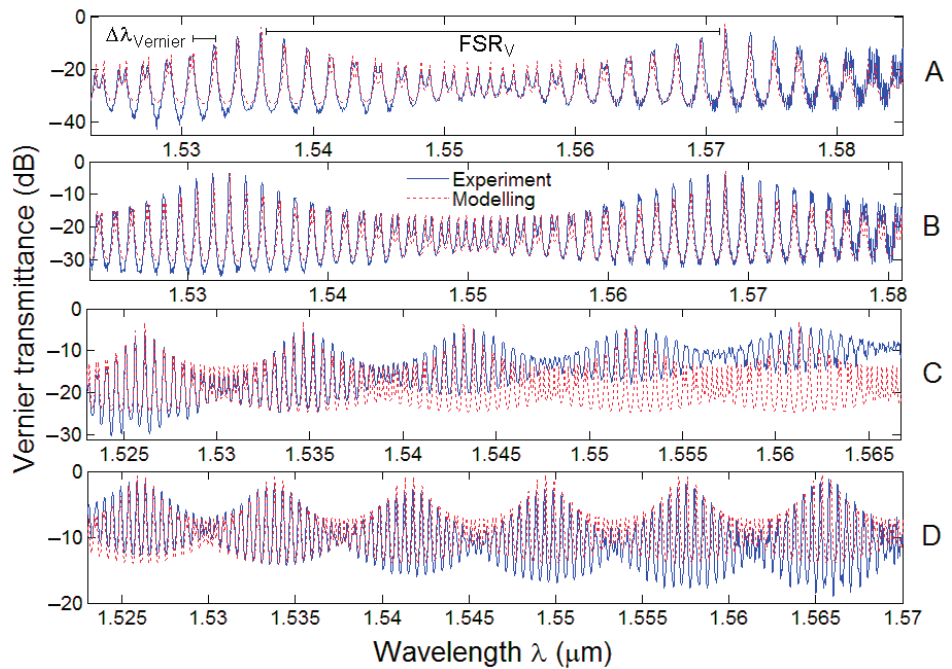
Figure 9. Normalized experimental transmittances (blue solid line) compared with theory (red dashed line) for Vernier A, B, C, and D